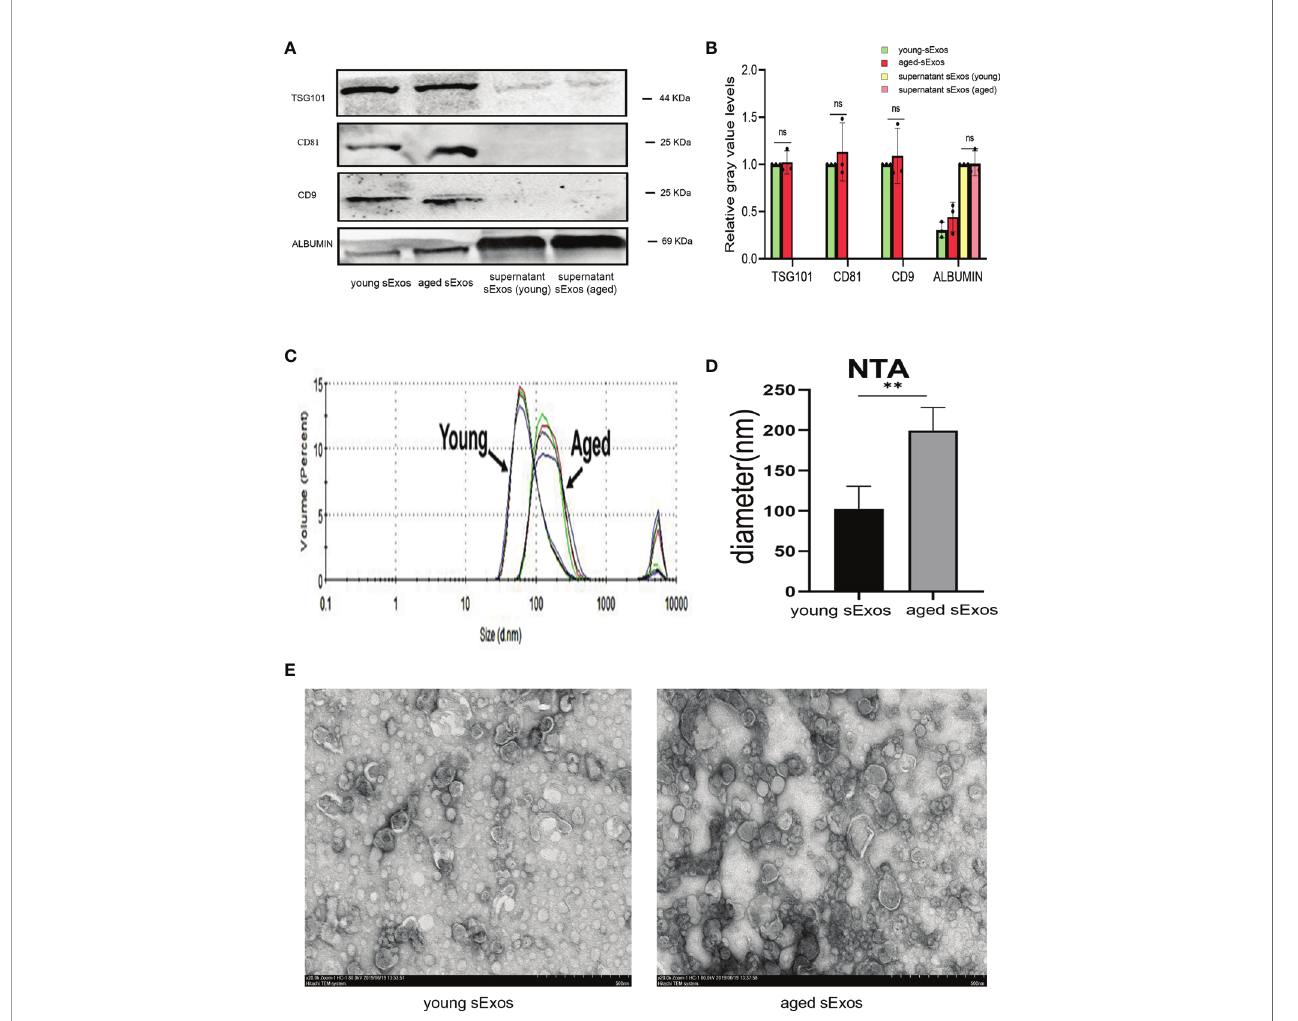
FIGURE 5 | Characterization of sExos extracted from young and aged male mice. (A) Western blotting analysis on sExos using antibodies against the positive markers (TSG101, CD81, and CD9) and negative marker Albumin after BCA (Bradford) protein quanti fi cation assay. (B) Quanti fi cation of band intensity as seen in panel (A, C) Representative particle size distribution diagrams of sExos from two groups of mice as determined by nanoparticle tracking analysis. (D) Quanti fi cation of panel C (mean ± SD, n = 6). (E) TEM images of sExos isolated from young and aged male mice. Bar = 500 m m. The differences between two groups were assessed by paired-samples t-test. **p < 0.01. sExos, seminal plasma exosomes; BCA, bicinchoninic acid; TEM, transmission electron microscopy; BMDC, marrow- derived dendritic cell; SP, seminal plasma; DC, dendritic cell; ns, not signi fi